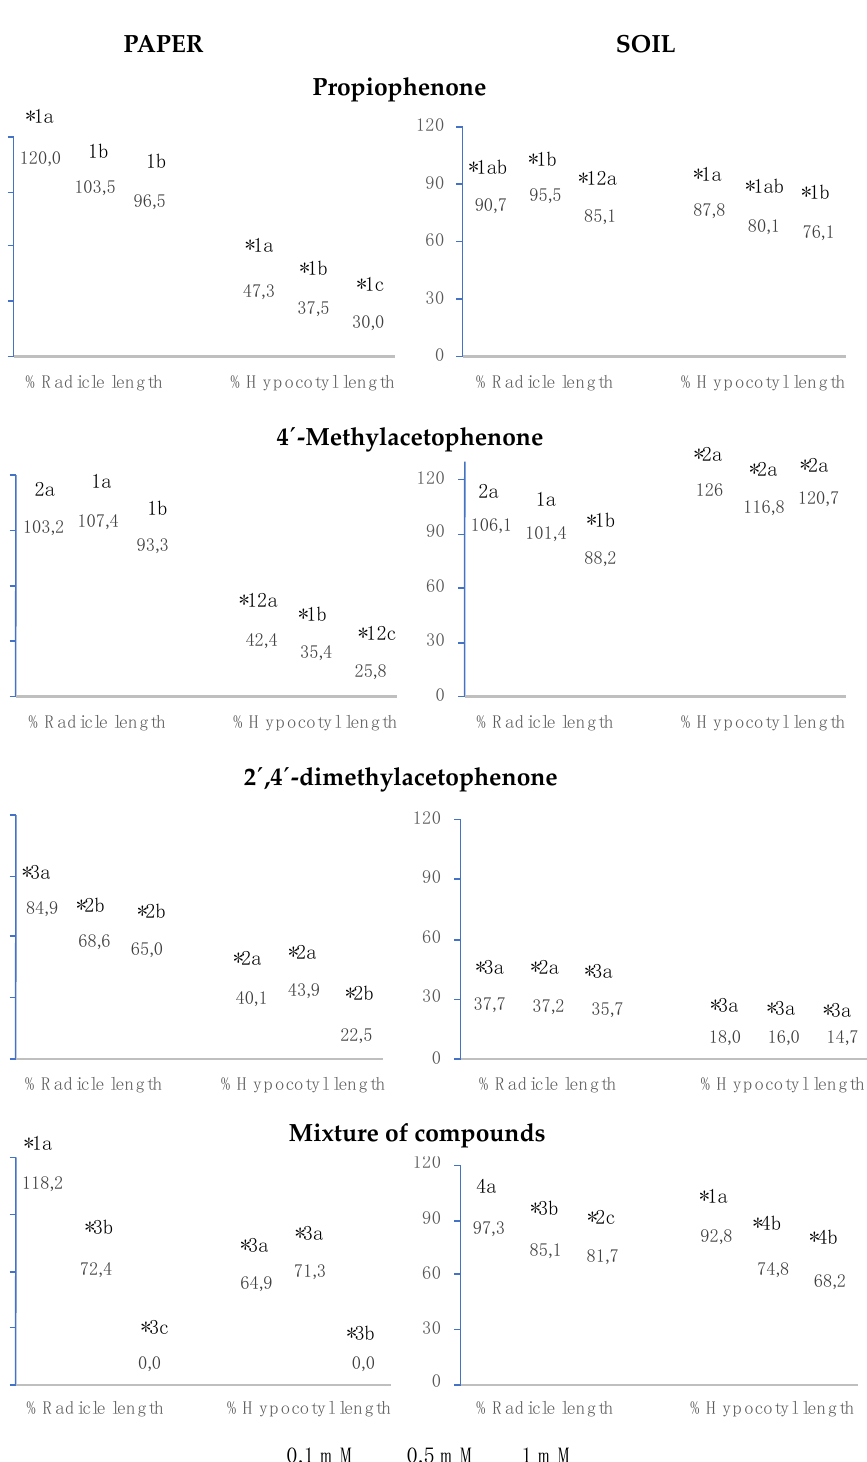
Figure 3. The effect of different concentrations of propiophenone, 4 ′ -methylacetophenone, 2 ′ ,4 ′ -dimethylacetophenone, and the mixture of the three compounds on the radicle and hypocotyl length of Lactuca sativa , expressed as the percentage relative to the control. Four replicates of each treatment were performed (n = 4 × 50 = 200 seeds in total for each solution). * Significantly different from the controls; 1, 2, 3, and 4: differences numbers indicate significant differences between treatments of the same index and for each concentration. The a, b, c: differences in small letters indicate significant differences between concentrations of the same index and for each treatment. p < 0.05 (Mann–Whitney U test).